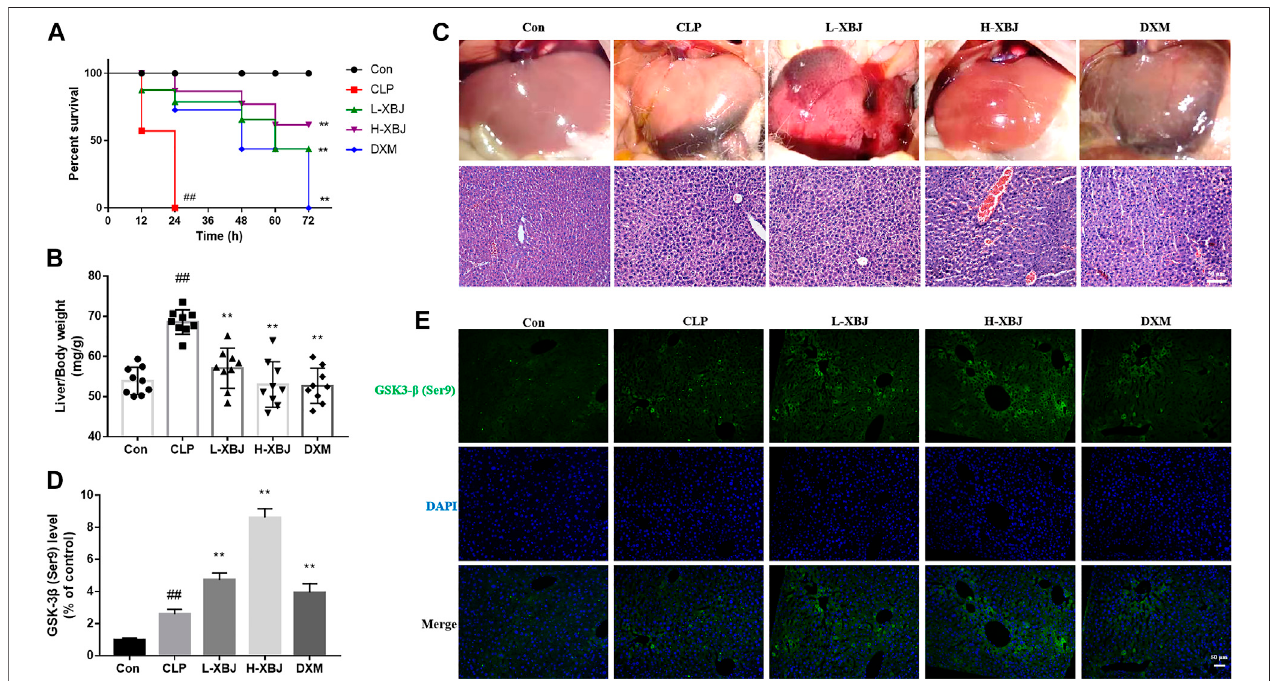
FIGURE1| XBJalleviatesacuteliverinjury(ALI)inC57BL/6micewithcecalligationperforation(CLP)sepsis (A) XBJimprovedsurvivalinmicewithALIfromsepsis. (B) XBJ reduced liver/body weight in mice with ALI from sepsis (C) Phenotype and H and E staining of livers from each group of ALI mice. (D) Representative images of GSK-3 β immuno fl uorescence in vivo (E) The expression of GSK-3 β in liver of mice with ALI. Con, control group that underwent sham surgery; CLP, model group with CLP surgery; L-XBJ: group with CLP surgery + XBJ low dose group (4 ml/kg/day); H-XBJ: group with CLP surgery + XBJ high dose group (8 ml/kg/day); DXM: group with CLP surgery + Dexamethasone (5 mg/kg/day). Compared with the control group, # p < 0.05, ## p < 0.01 were considered to be signi fi cant; Compared with the CLP group, * p < 0.05, ** p < 0.01 were considered to be signi fi cant. Data are expressed as mean ± SD.